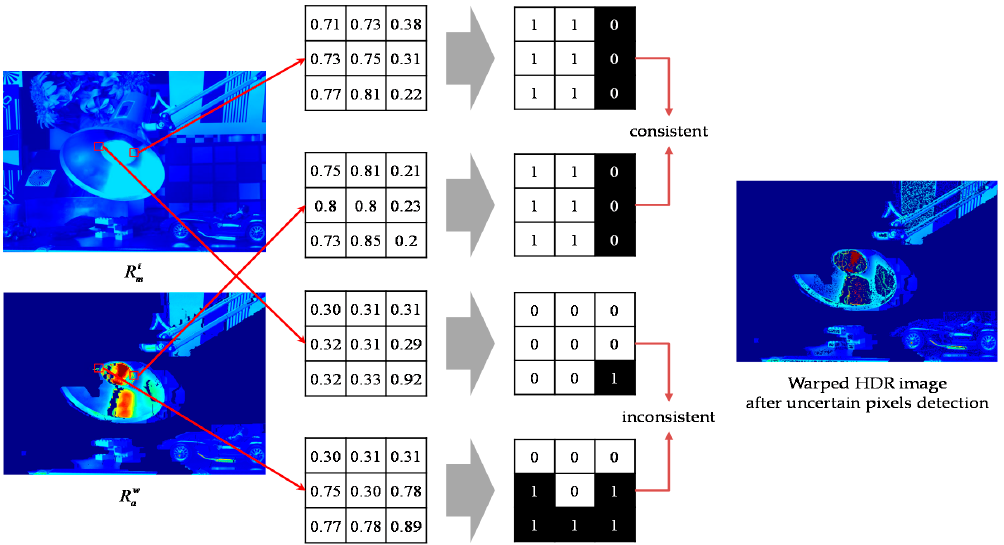
Figure 10. An example of the uncertain pixel detection.